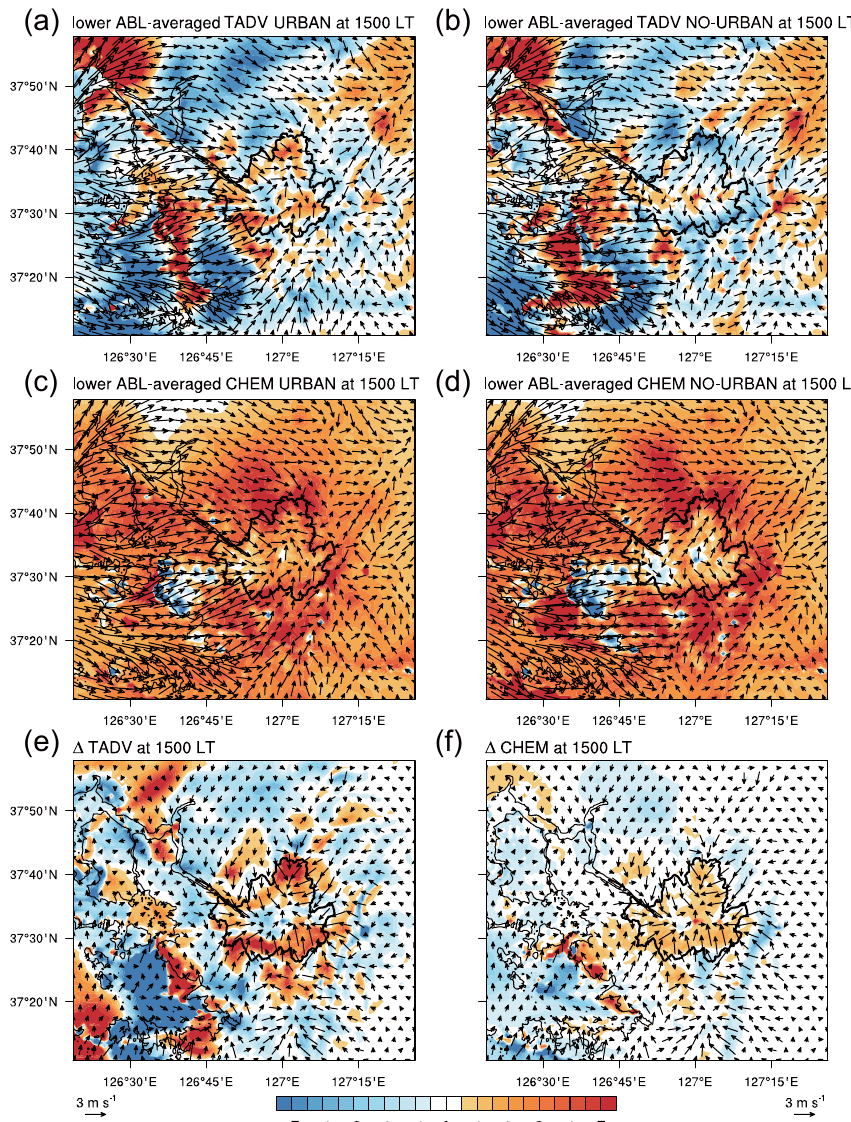
Fig. 9. Horizontal distributions of column-averaged contributions of the (a) advection process and (c) chemical process to O 3 concentration in the lower ABL at 15:00 LT in the URBAN simulation. (b) and (d) are the same as (a) and (c) , respectively, but for the NO-URBAN simulation. (e) and (f) show the differences in the contributions of the advection and chemical processes between the two simulations, respectively. The units are ppbh − 1 . The horizontal winds are the winds at the lowest model